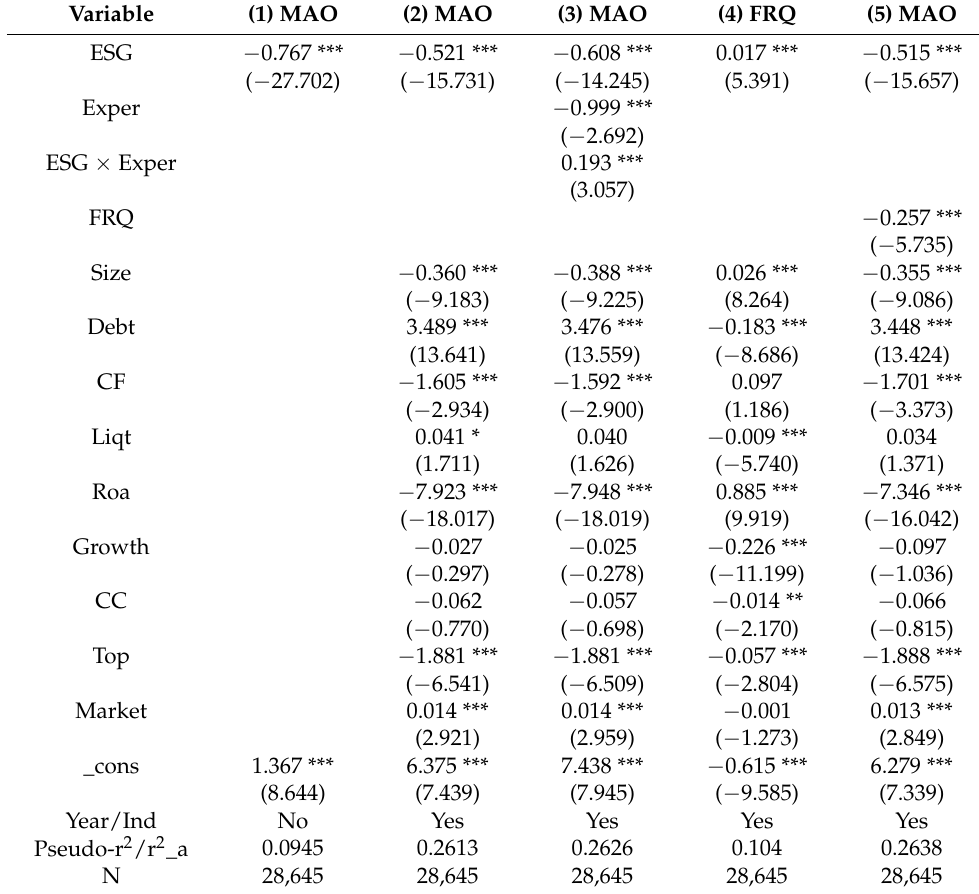
Table 4. Regression